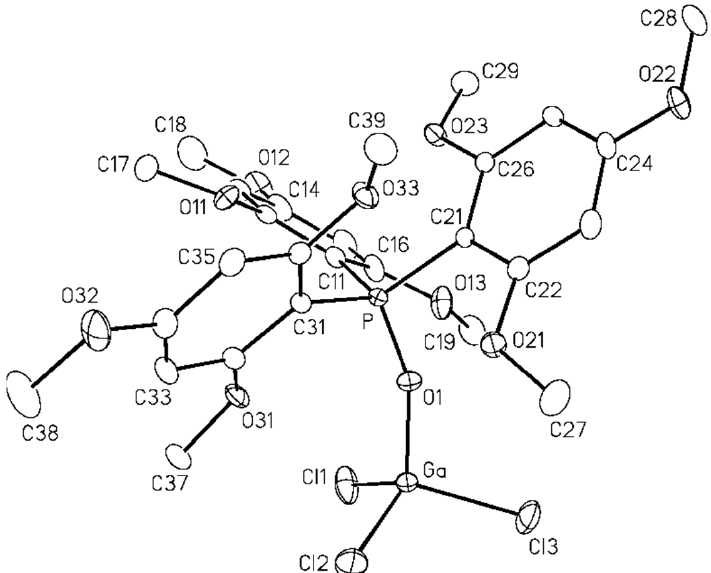
Figure 1. Perspective view of the [{tris(2,4,6-trimethoxyphenyl)phosphine oxide}GaCl 3 ] (1) molecule, showing the atom labeling scheme.